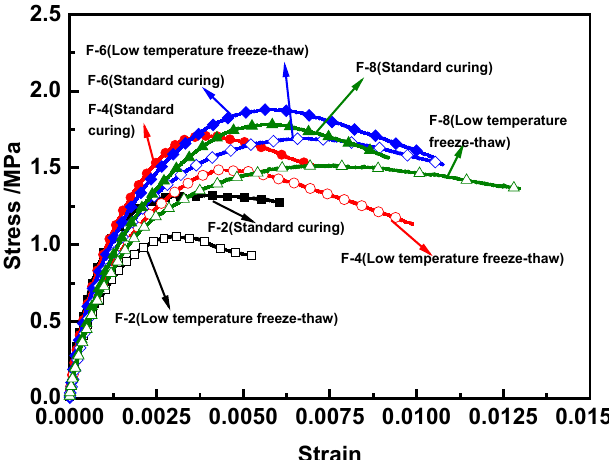
Figure 11. Stress-strain curve of stabilized silt under standard curing and low temperature freeze-thaw.